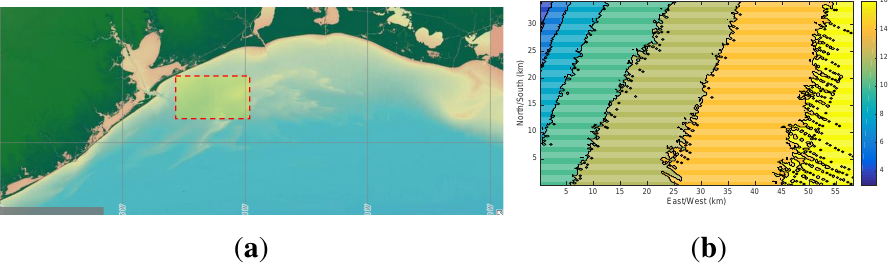
Figure 11. ( a ) Areal view, with the domain of the computation, highlighted. South Etast of Galveston, TX, USA; ( b ) bathymetry of the region